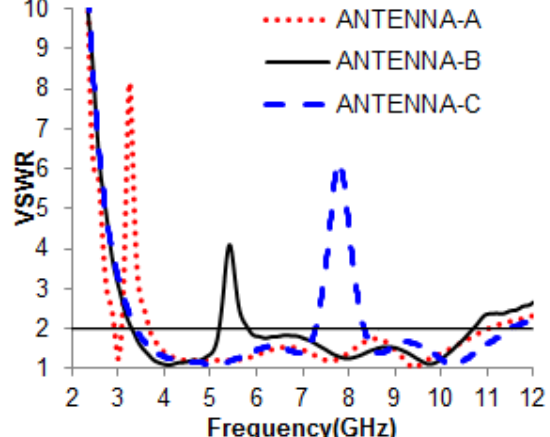
Figure 4: Comparison of VSWR plots for Antenna-A, Antenna-B, and Antenna-C of Fig. 3.